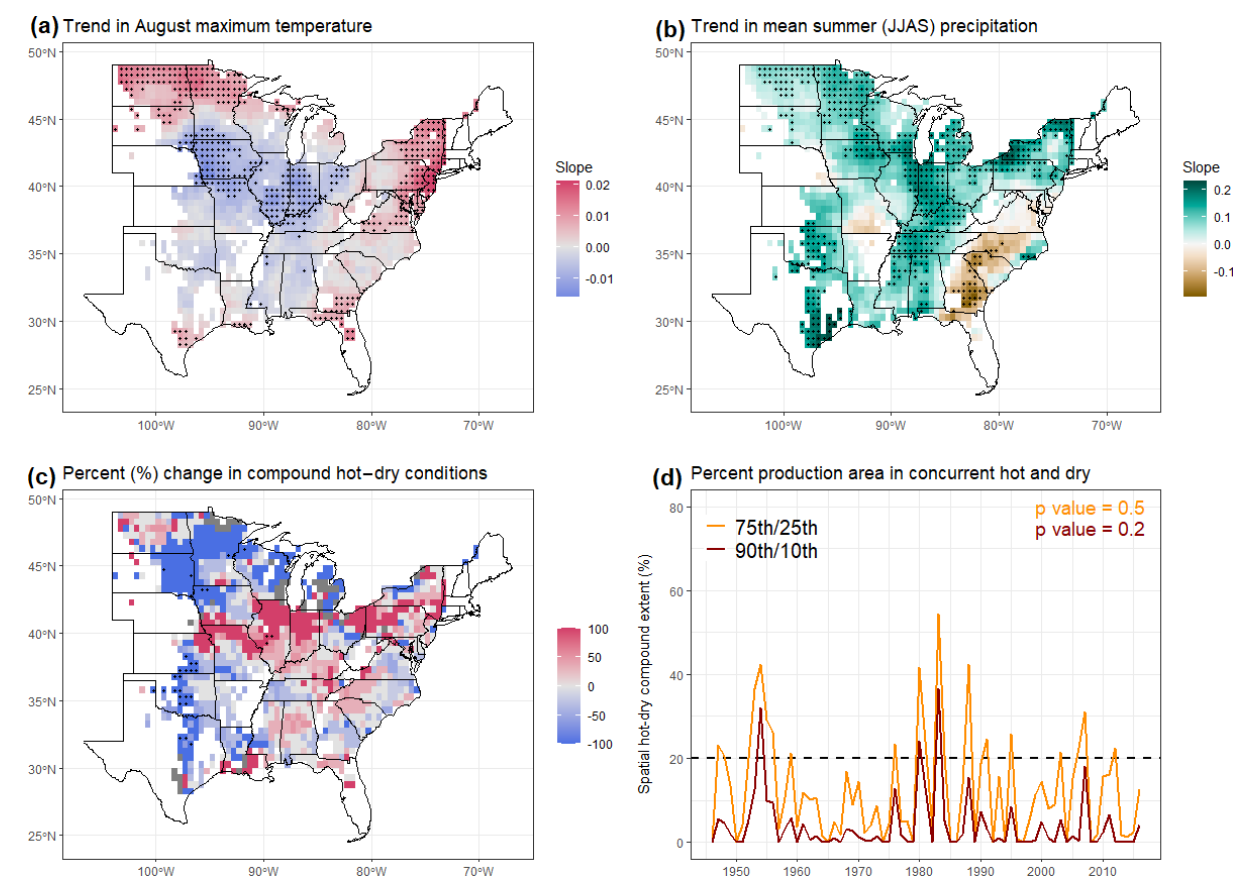
Figure 6. (a) Linear regression slope of August maximum temperature. (b) Linear regression slope for summer (JJAS) precipitation. (c) Per- cent (%) change in concurrent dry (summer JJAS precipitation < 10th percentile) and hot (August maximum temperature > 90th percentile) conditions during 1982–2016 relative to 1946–1980. (d) Time series of percent production area under hot and dry conditions. Trends in Pan- els (a) , (b) and (d) are calculated for the period from 1946 to 2016. The stippling in panels (a) , (b) and (c) indicates statistical significance at the 95% confidence level. The p values in panel (d) correspond to the Mann–Kendall monotonic trend test. The black dashed line in panel (d) represents a 15% threshold marking years with a large ( > 15%) hot–dry spatial